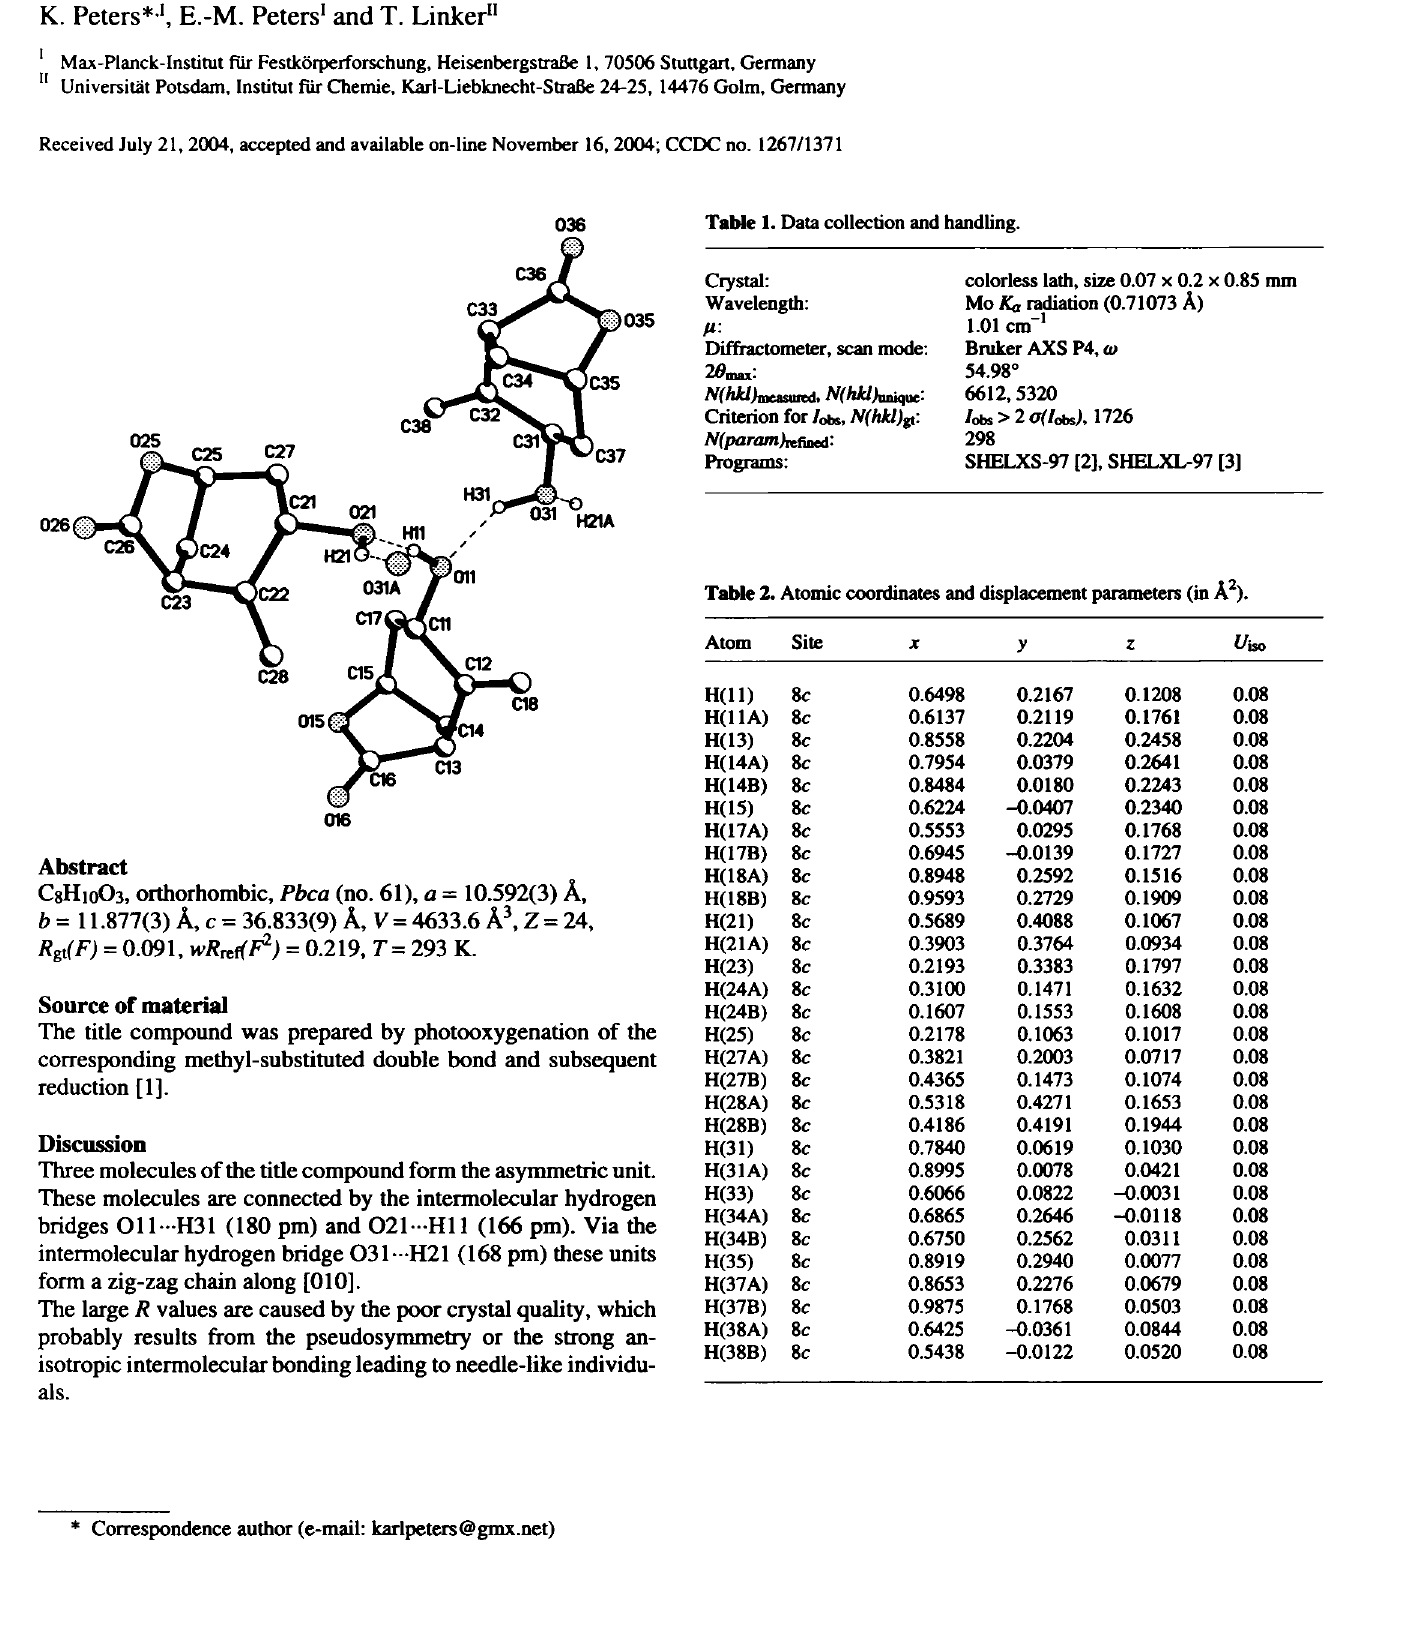
Table 1. Data collection and handling.